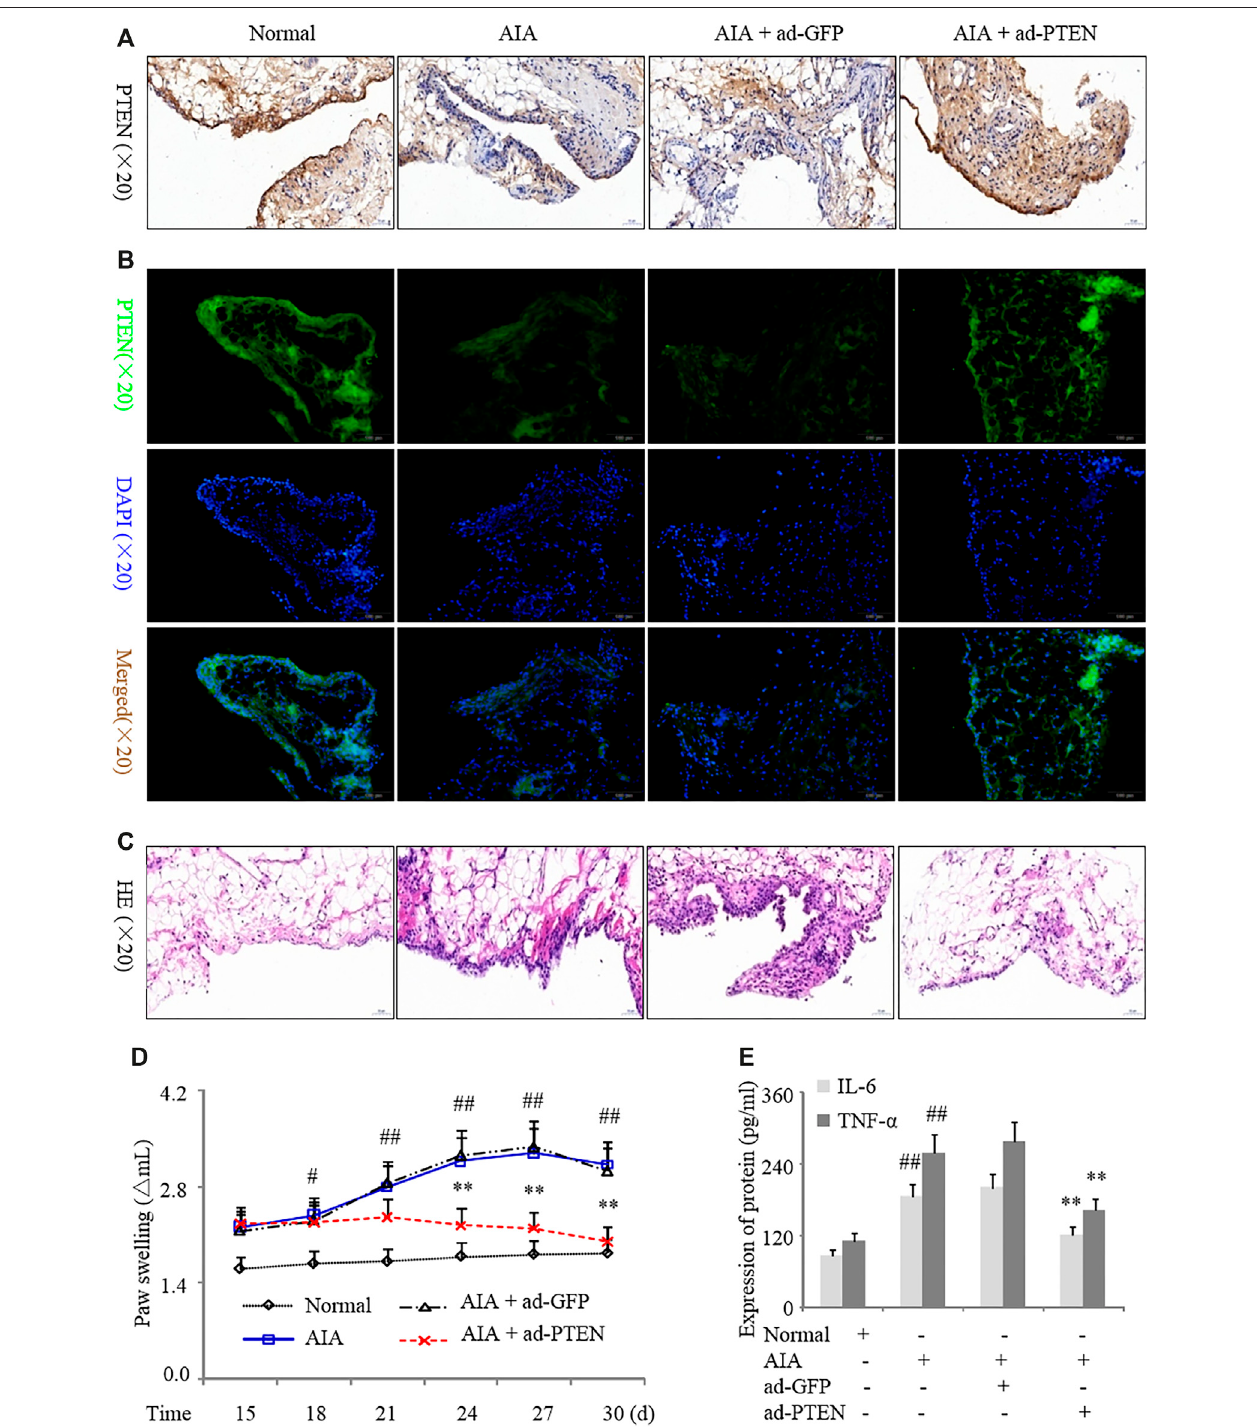
FIGURE6| PTENoverexpressionsuppressesin fl ammationinaratAIAmodel.AIAmodelratsweretreatedwithAd-GFPorAd-PTENbyintra-articularinjection. (A, B) Representative images of PTEN immunoreactivity in synovium detected by immunohistochemistry (A) and immuno fl uorescence analysis (B) . (C) Representative images of hematoxylin and eosin staining in the synovium. (D) Paw swelling. (E) Serum IL-6 and TNF- α protein levels detected by ELISA. Values are expressed as mean ± SD. # p < 0.05, ## p < 0.01 vs. normal group; * p < 0.05, ** p < 0.01 vs. Ad-GFP group.